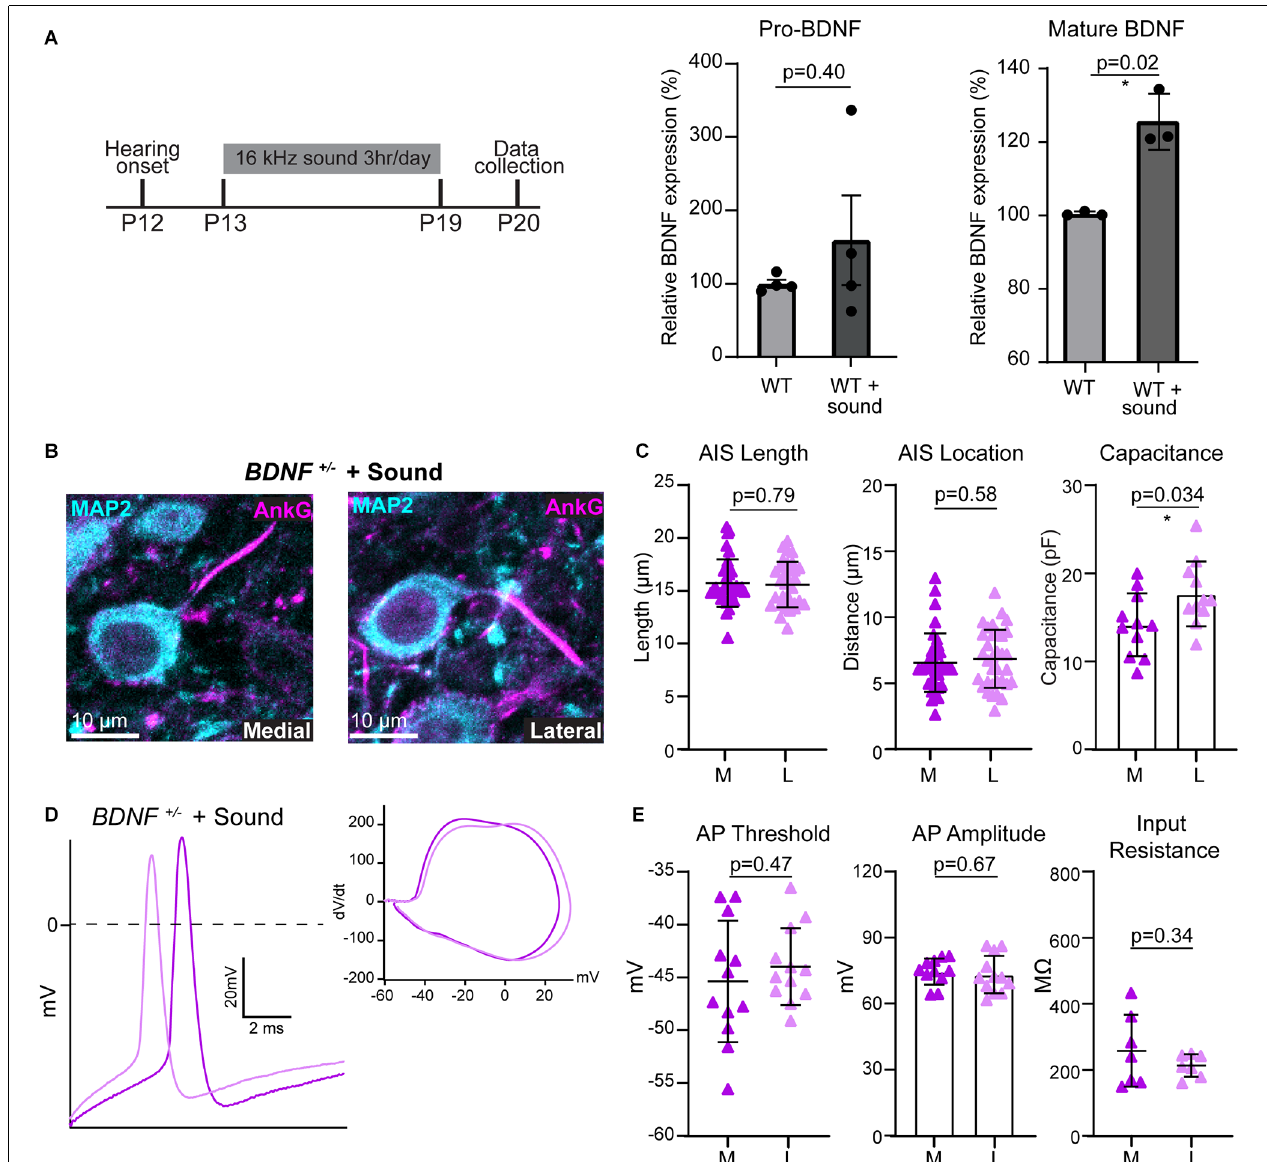
FIGURE 4 | BDNF is necessary for the activity-dependent plasticity of MNTB neurons. (A) Sound stimulation paradigm schematic; 16 kHz sound for 3 h/day from P13 to P19 followed by data collection and mature and pro-BDNF protein levels in WT and WT + sound. * indicates p < 0.05. (B) MNTB neurons of BDNF + / − mice following sound stimulation were immunostained with anti-MAP2 (cyan) and anti-AnkG (magenta). (C) AIS length and location, and cell size were quantified by condition and tonotopic location. Each point represents individual cells from four mice for BDNF + / − and three mice for BDNF + / − + sound. (D) Representative AP traces from BDNF + / − medial (dark purple) and lateral (light purple) neurons after sound stimulation. Inset, dV/dt phase plot against membrane potential. (E) Summary of AP threshold, amplitude, and input resistance were quantified for each condition and tonotopic location. Each point represents an individual